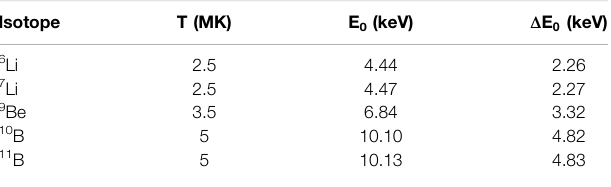
TABLE 1 | Central energy and width of the Gamow windows for the proton- induced reactions on LiBeB at temperatures, typical of their stellar burning as discussed in Section 1 , expressed in millions of